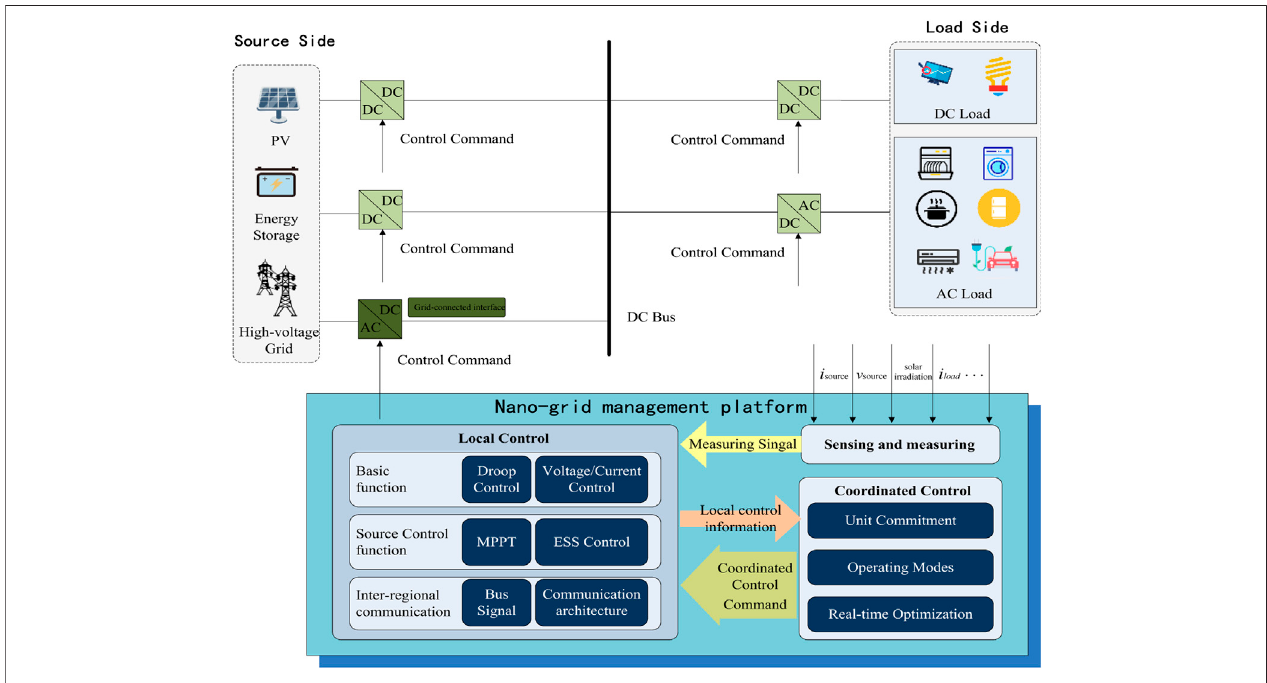
FIGURE 1 | Physical and control structure of